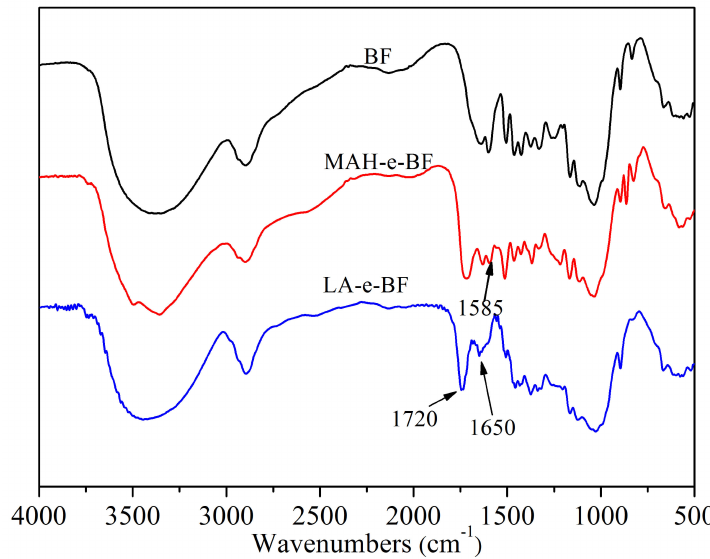
Figure 3. Infrared spectrogram of BF, Maleic anhydride-esterified-bamboo flour (MAH-e-BF), and lactic acid-esterified bamboo flour